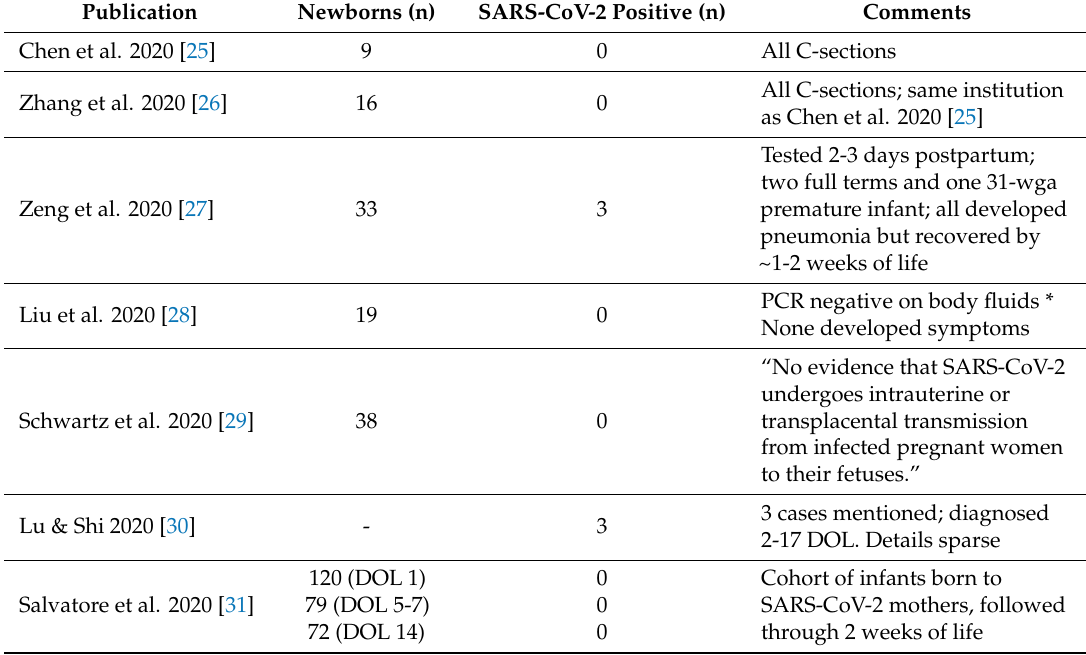
Table 2. Selected reports evaluating potential vertical transmission of